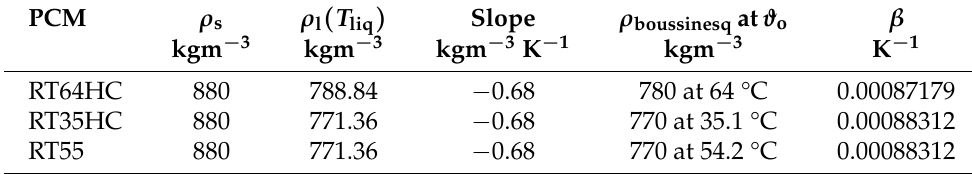
Table 2. Density parameters used for variable density and Boussinesq